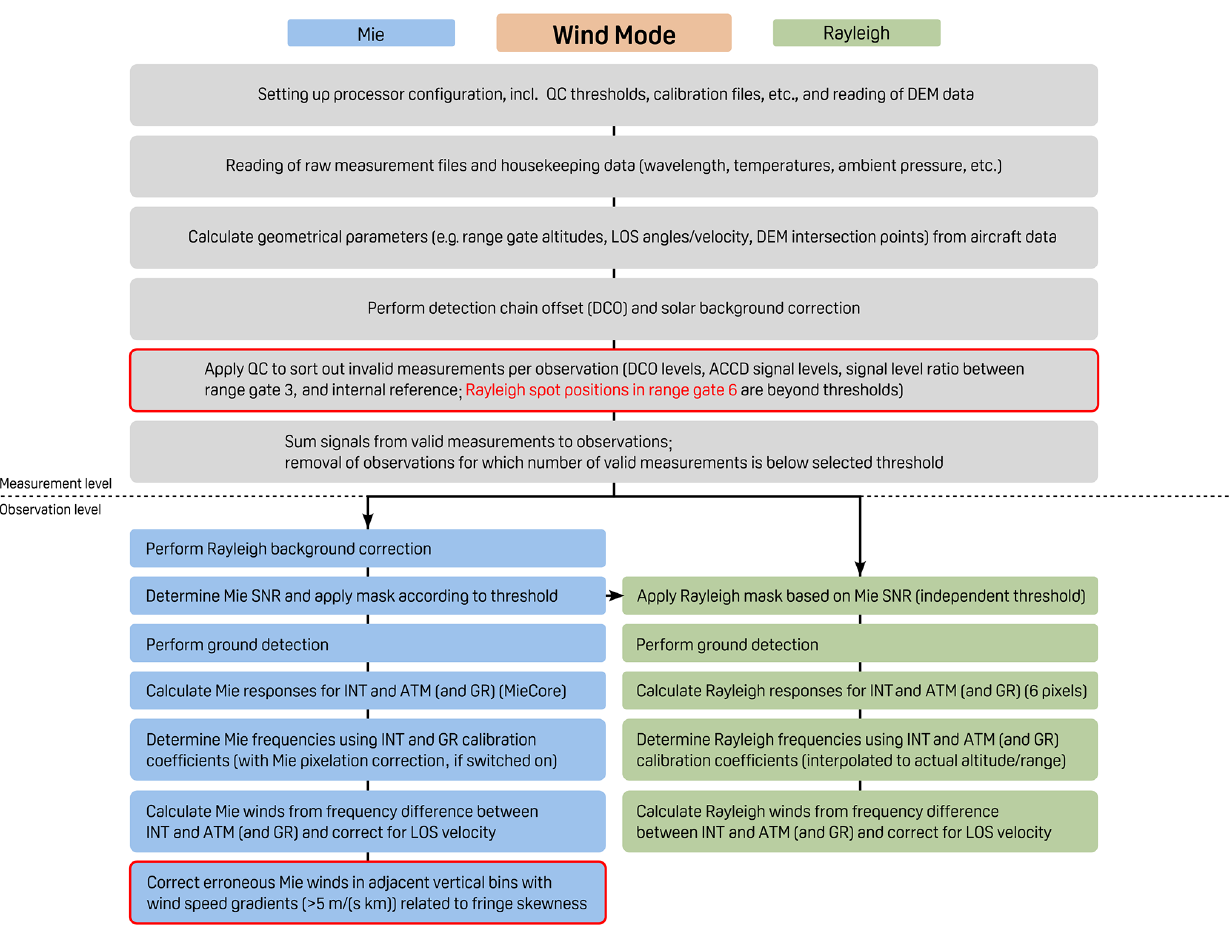
Figure 4. Flow chart of the A2D wind retrieval. Refinements that were introduced in the course of the AVATARE and AVATARI data analysis are indicated as red-framed boxes. Note: INT – internal path; ATM – atmospheric path; GR – ground